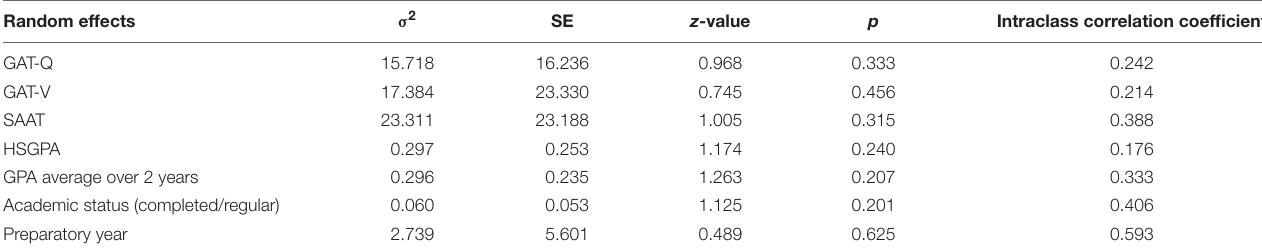
TABLE 5 | Random effects of all variables and intraclass correlation coefficient at